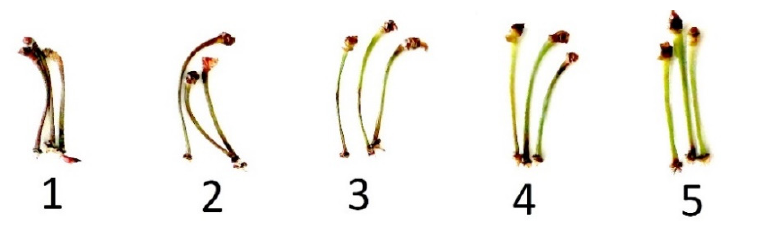
Figure 3. Scale used to classify the aspects of stems, ranging from 1 (completely brown and dehydrated) to 5 (completely green and fresh).